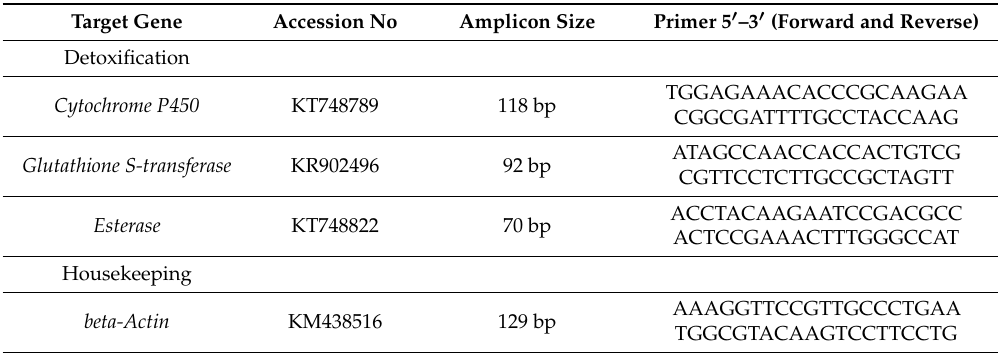
Table 3. Target genes and primer sequences used for quantitative PCR expression analysis of detoxification genes from red palm weevil